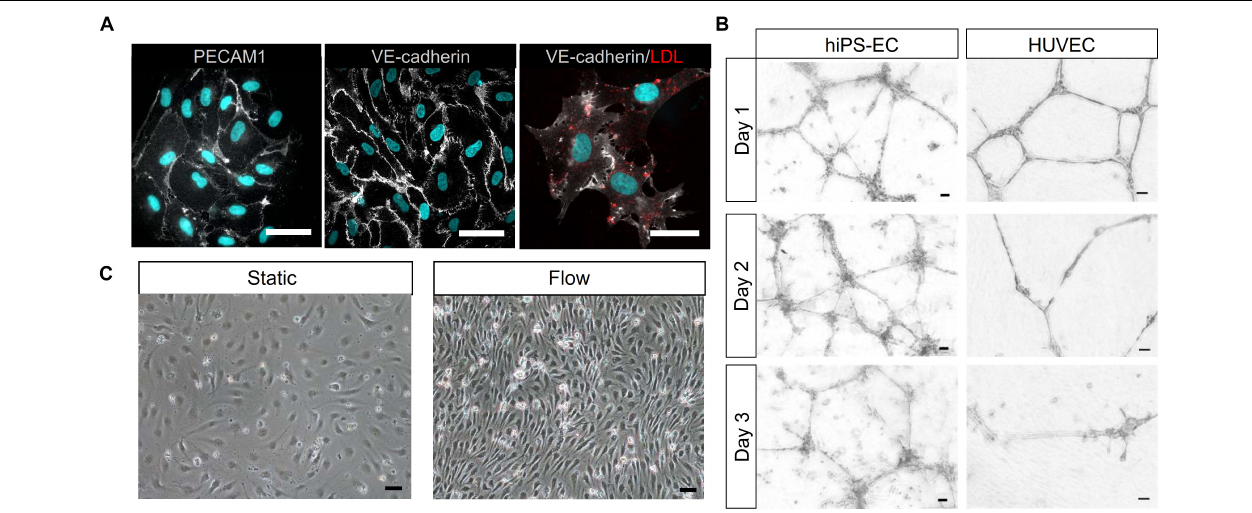
FIGURE 1 | Characterization of hiPS-ECs. (A) , PECAM1 and VE-cadherin IF staining of hiPS-ECs (white) and uptake of oxLDL by hiPS-ECs (red). Nuclei are shown in blue. Scale bar 50 µ m. (B) , Matrigel tube assay of hiPS-ECs and HUVECs (scale bar 50 µ m). The cells were plated on Matrigel and imaged every day for 72 h. (C) , Phase-contrast images of hiPS-ECs after 24 h exposure to flow-induced shear stress and under static conditions. The cells in both conditions are from the same differentiation batch and images have been taken at the same time point just before processing them for scRNASeq. Scale bar 50 µ m.